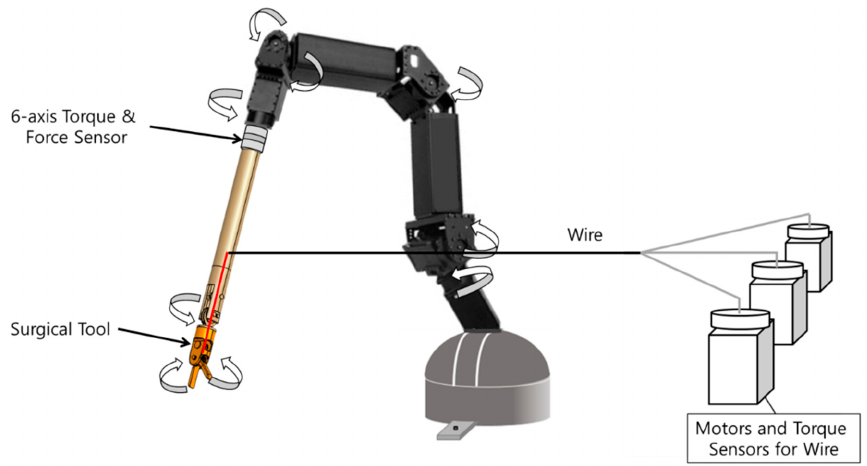
Figure 13. Overall configuration of the slave